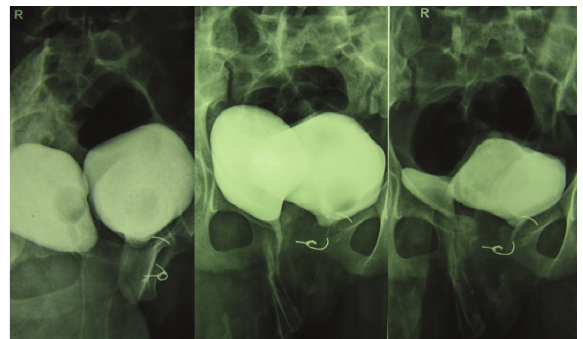
Figure 1: Voiding cystourethrography showing complete bladder duplication with pubic diastasis and sacral hypoplasia.